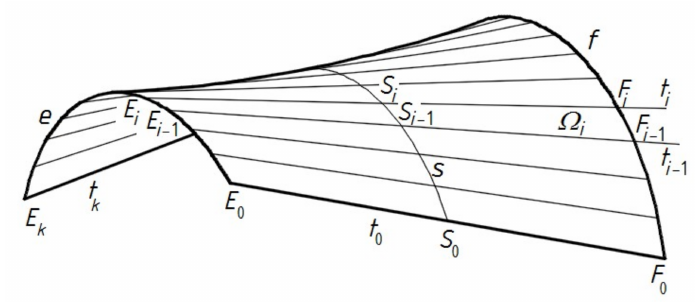
Figure 5. Simplified smooth shell model of a transformed shell roof with the s line of striction and rulings t i modeling the longitudinal borders of subsequent folds in a